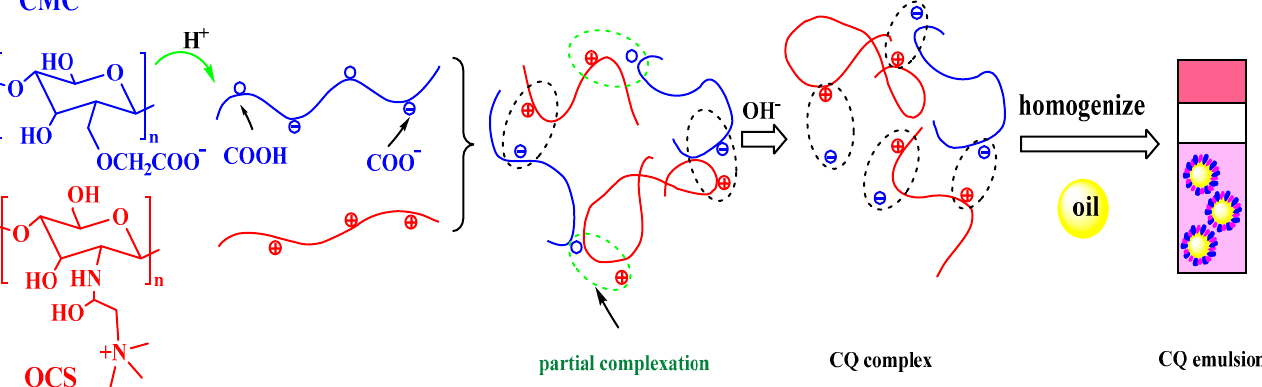
Figure 2. Scheme for the formation of the CQ complex [41]. Copyright 2021 Elsevier Ltd.